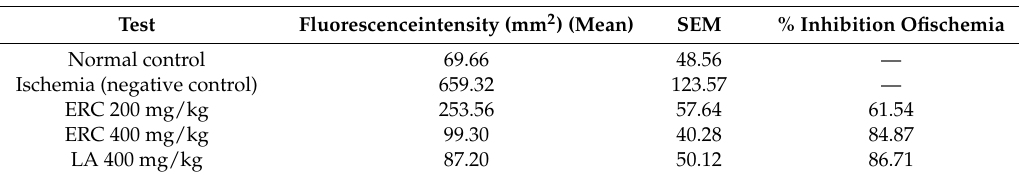
Table 3. Comparison of fluorescence intensity (mm 2 ) and % of ischemia inhibition in treated and control groups.